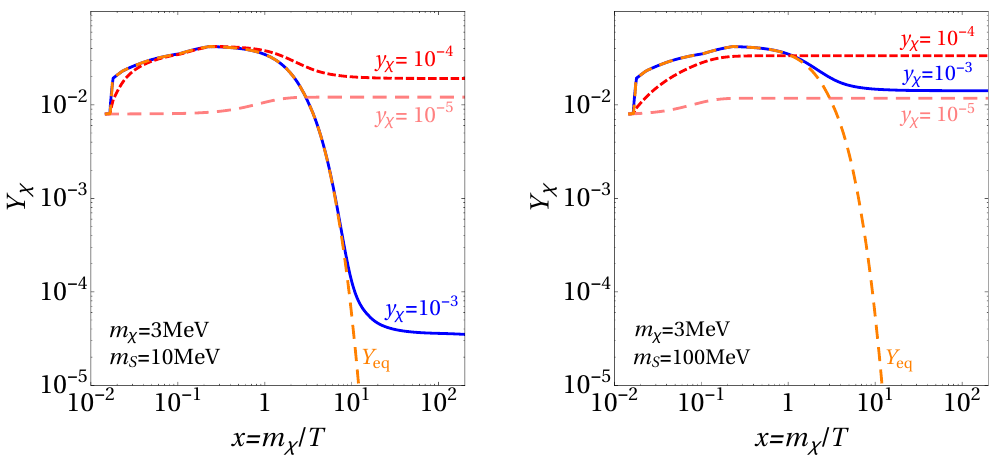
Figure 7 . In left (right) panel we show the evolution of Y (cid:31) for several di(cid:11)erent values of y (cid:31) with (cid:12)xed m (cid:31) = 3 MeV and m S = 10 MeV ( m S = 100 MeV). For larger couplings, characteristic freeze-out curves are easy to identify whereas (cid:31) is \frozen-in" for weaker (cid:31)(cid:31) the latter scenario, the (cid:31) abundance is set primarily by the initial condition, i.e. not-vanishing Y (cid:31) at T QCD